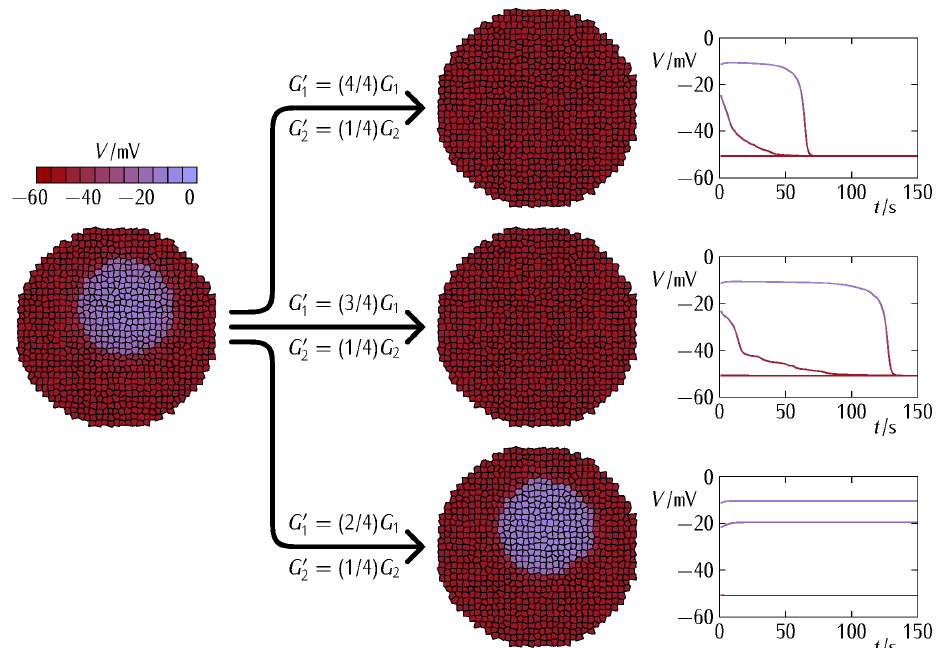
Figure 5. The cell system changes due to a decrease in the conductances G 1 and G 2 to the new values G (cid:48) (three different decreases) and G (cid:48) (fixed decrease) shown in the figure ( left ). At fixed G 2 decrease, a minimum value of G 1 is needed for the surrounding bulk to force the polarization of the patch ( left , intermediate ). For a lower system connectivity (a lower value of G 1 ), the patch is effectively isolated from the surrounding bulk region and cannot be polarized ( left , bottom ). For a higher value of G 1 ( left , top ) on the contrary, faster patch polarizations are obtained ( right ). The rest of system parameters are those of Figure 4.